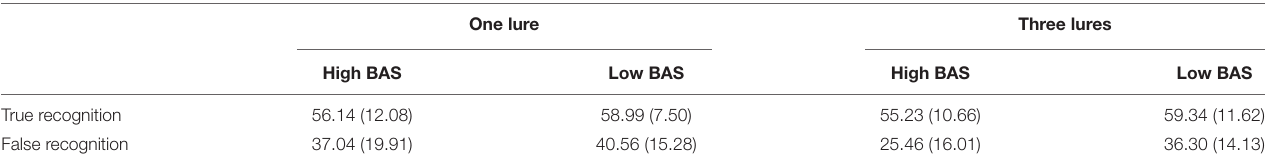
TABLE 3 | Mean Percentage (SD) of True and False Recognition After Removing Lists with 100% of True Recognition, as a Function of Number of Critical Lures per List at Test (one vs. three) and BAS (high vs.